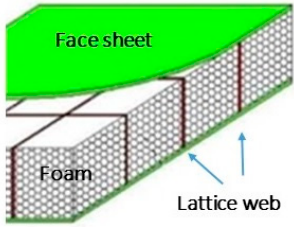
Figure 1. Foam-filled panel proposed by Wu et al. Adapted from [4]. Figure1. Foam ‐ filled panel proposed by Wu et al. Adapted from [4].